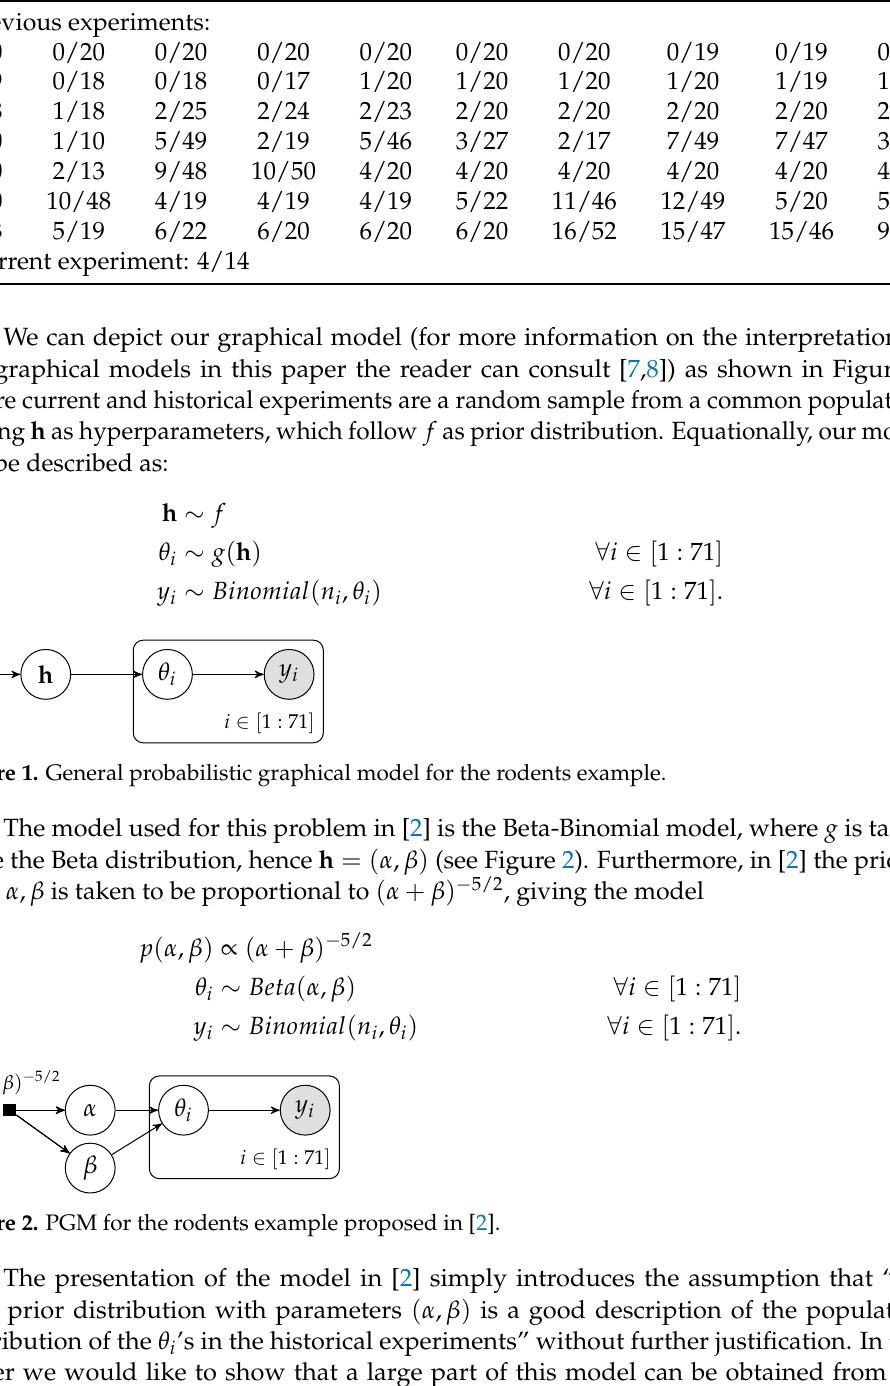
Table 1. Tumor incidence in 70 historical groups of rats and in the current group of rats (from [6]).